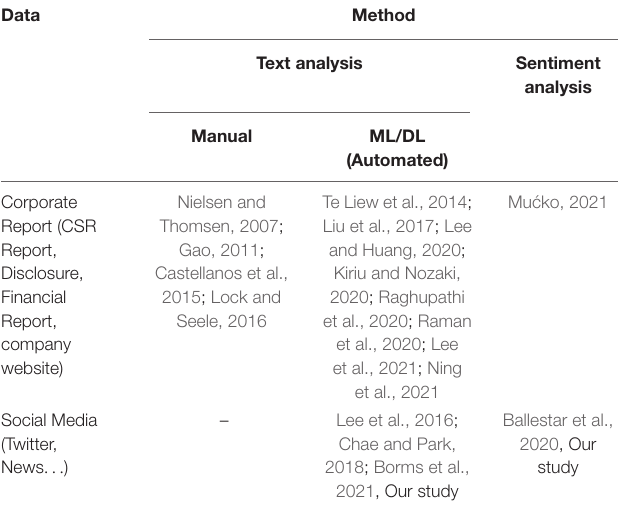
TABLE 1 | Text analysis (ML) and sentimental analysis about